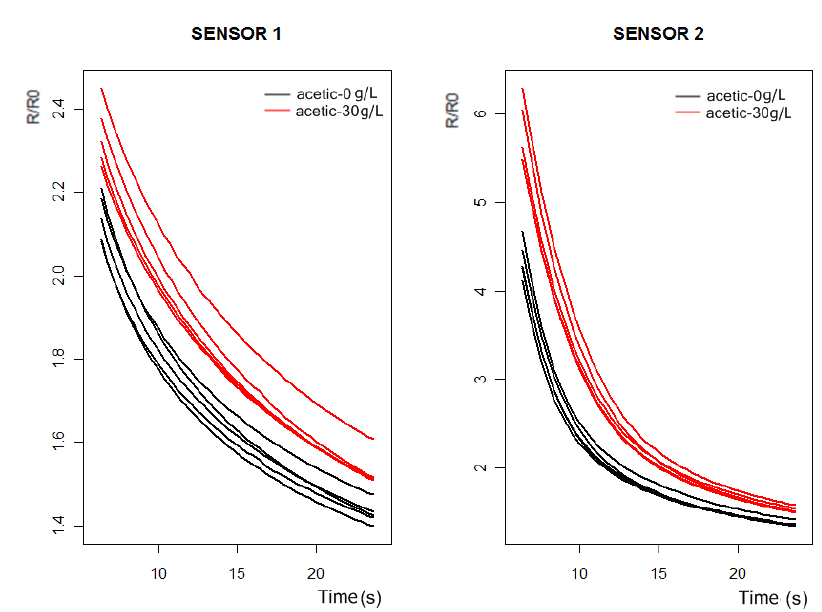
Figure 5. Response curves of the sensors 1 and 2 in the interval of 6 to 24